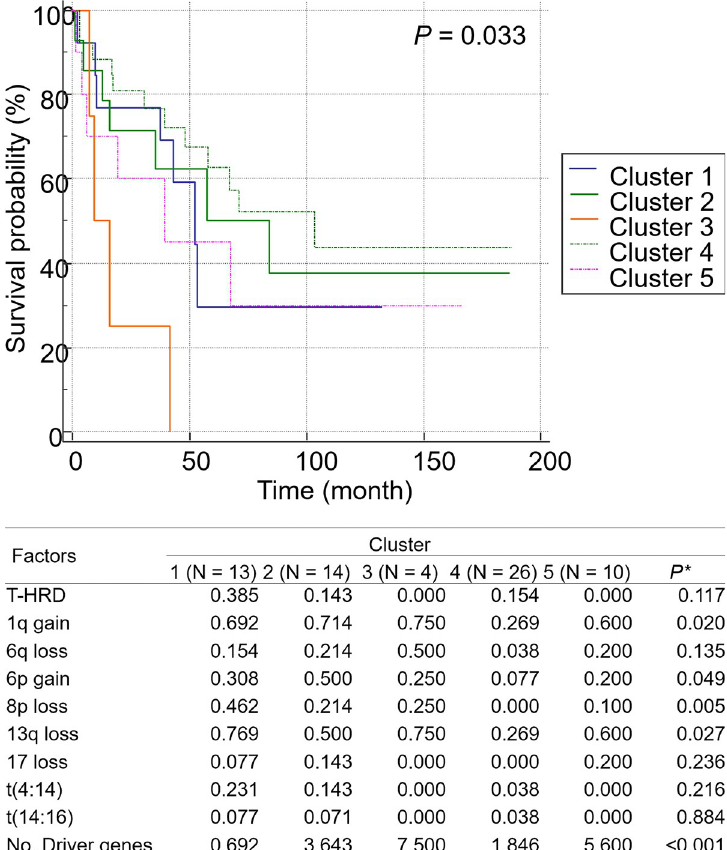
Fig 9. Kaplan-Meier curves for Overall Survival (OS) with subdivided driver groups. (A) The cluster 3 group exhibited significantly lower OS than clusters 1, 2, 4, and 5 ( P = 0.019). (B) Final cluster centers for variables, including those used for K-means analysis, are classified based on each cluster. The significant clustering factors were 1q gain, 6p gain, 8p loss, 13q loss, and the number of driver gene mutations ( P < 0.05). For example, the cluster 3 group, which exhibited the worst prognosis, had a clustering center with 1q gain, 6p gain, 13q loss, and driver gene mutation number of 7.5. � P-value was calculated using analysis of variance.